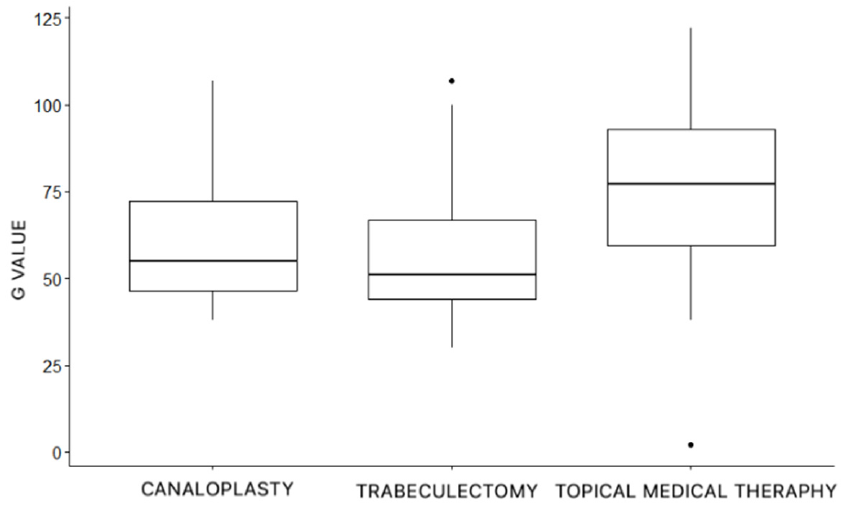
Figure 2. Global average thickness (G value) of the peripapillary retinal nerve fiber layer (pRNFL) in the three treatments groups.